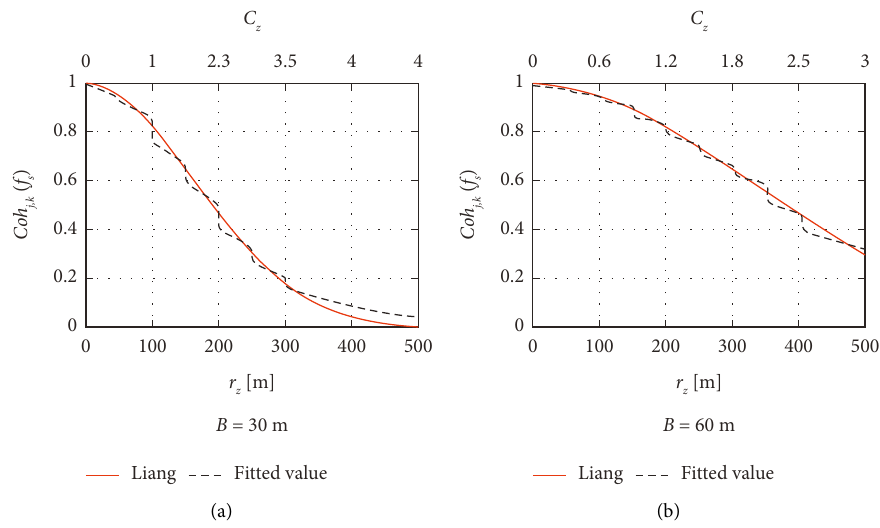
Figure 12: Vertical correlation at vortex shedding frequency for wind-induced torque: D/B �